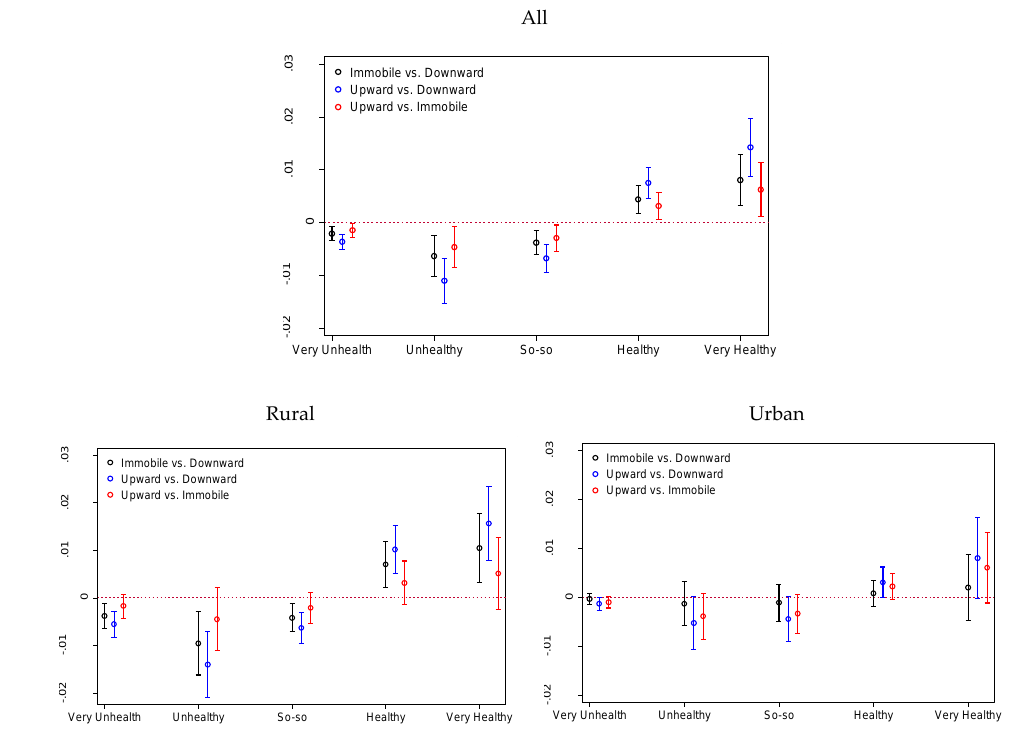
Figure 3. Average Partial Effect of Self-Perceived Class Mobility.